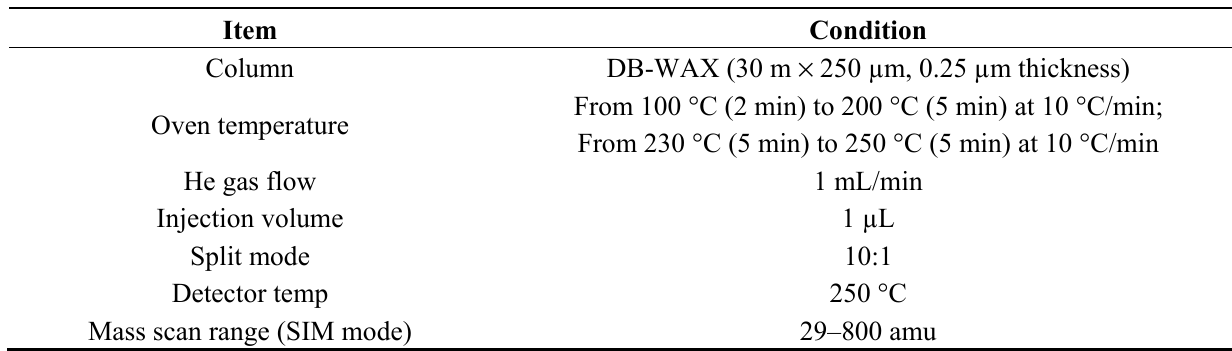
Table 1. Operation conditions of gas chromatography mass spectrometry (GC-MS) analysis used in this